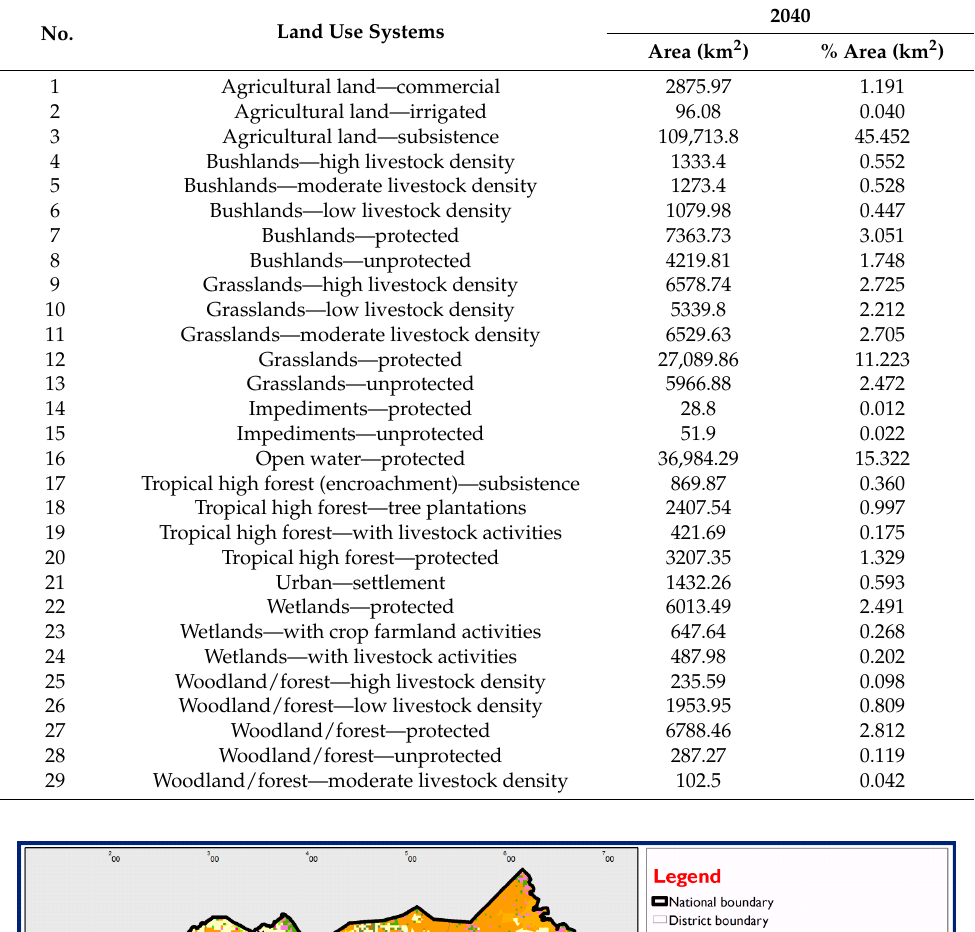
Table 4. Projected land use systems of Uganda for the year 2040.